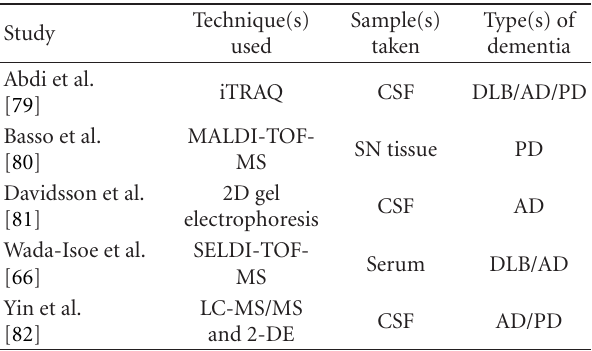
Table 5: Proteomic